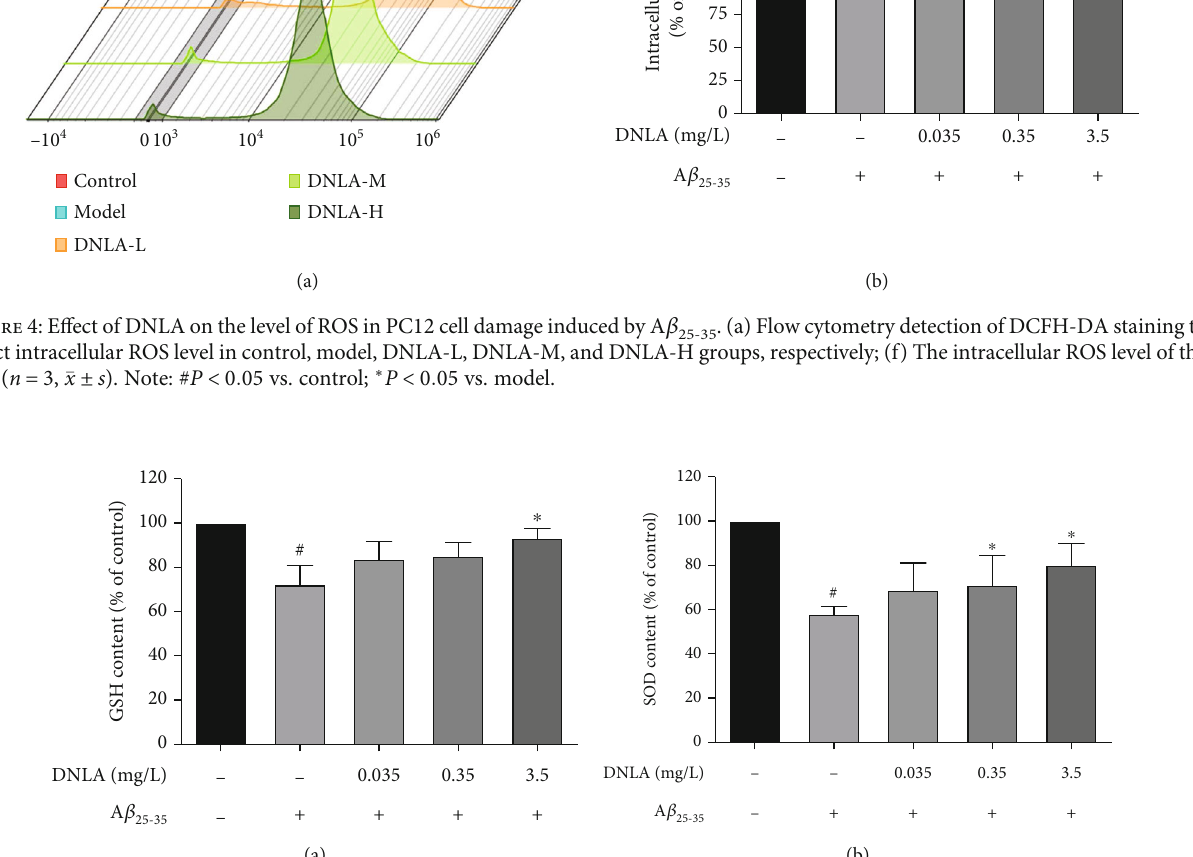
. (a) The intracellular GSH level in 25-35